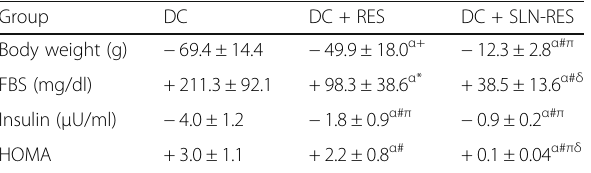
Table 2 The effect of RES and SLN-RES treatment on the body weight gain, fasting blood sugar, insulin, and HOMA index in diabetic rat